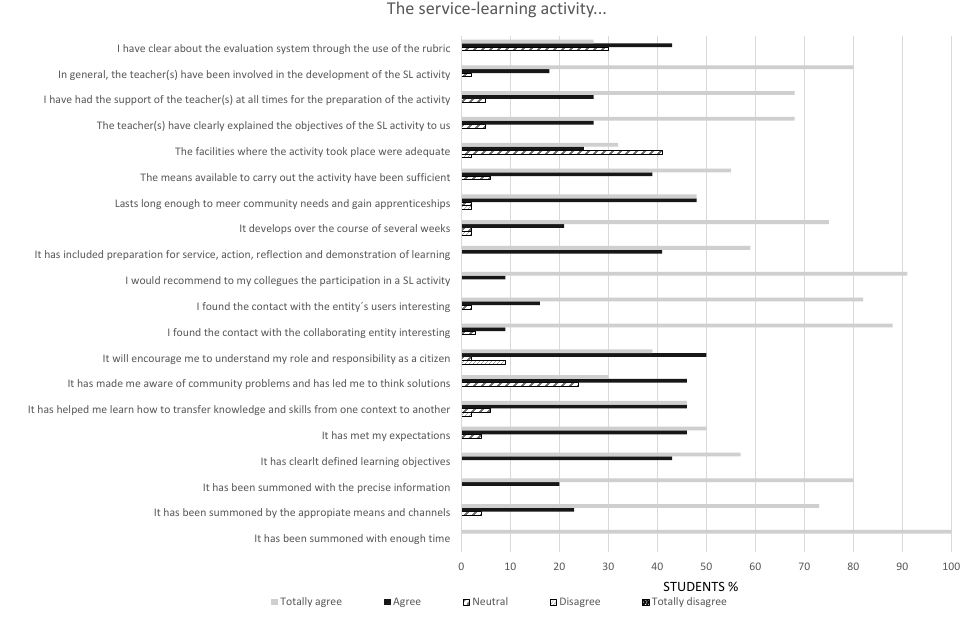
Figure 5. Results of the student’s satisfaction